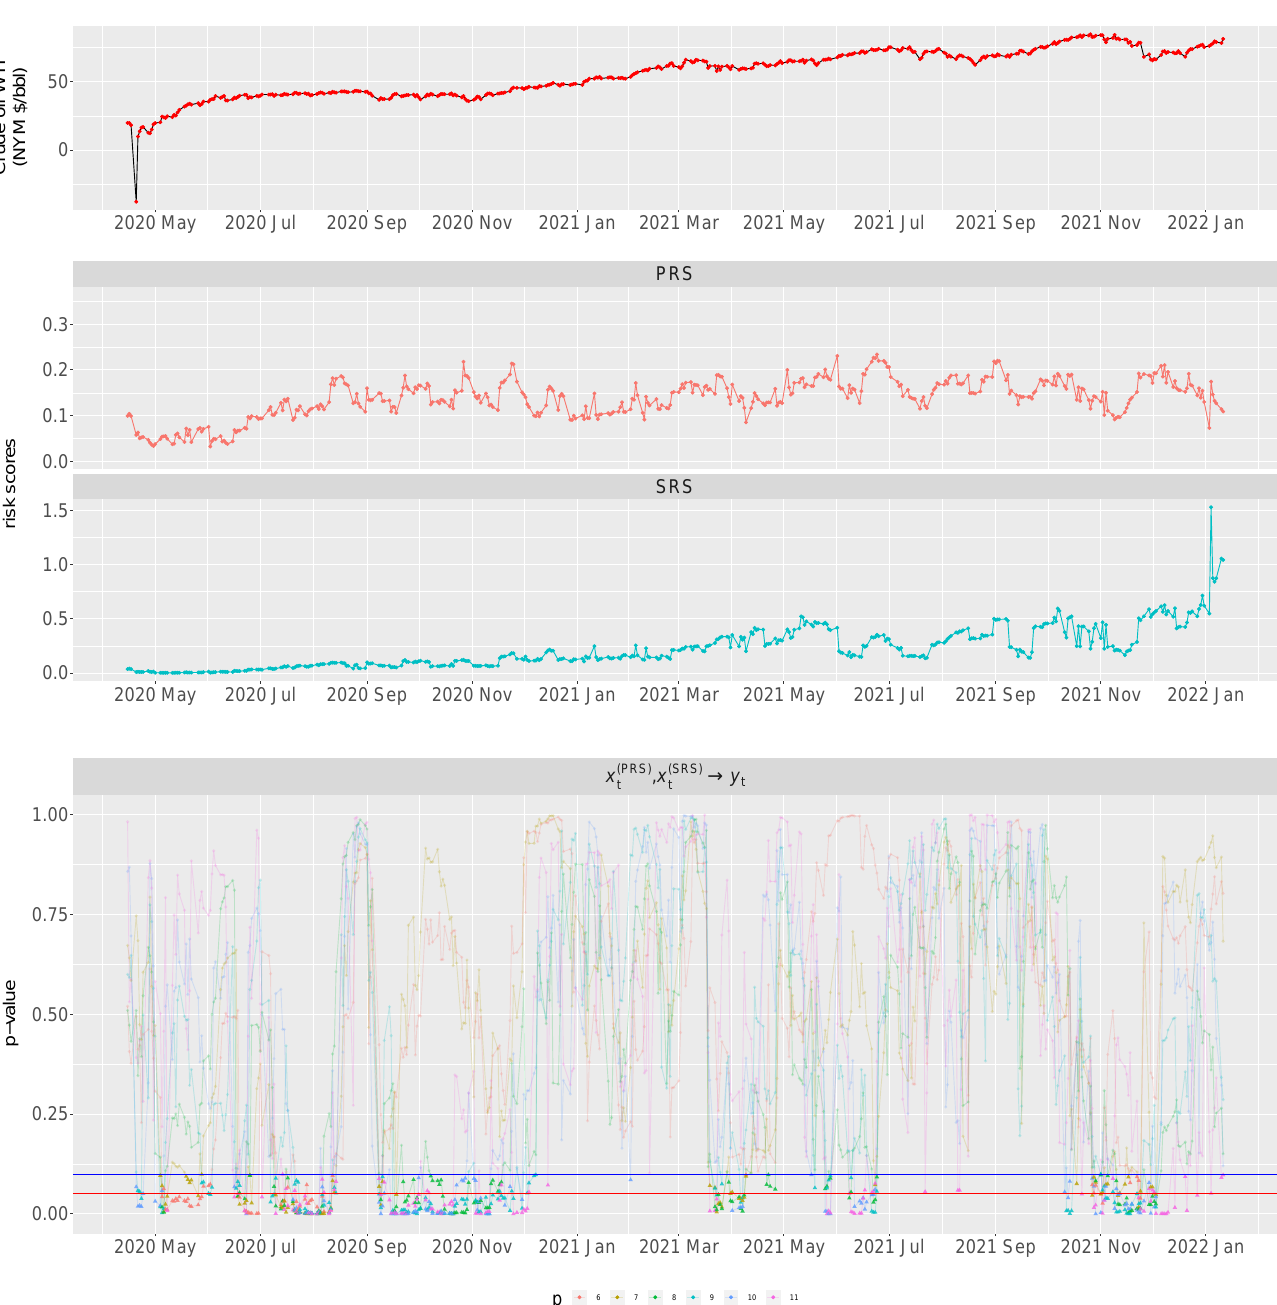
Figure 2. Time series plot of p -values (PRS and SRS; window width = 49; with different time lag p = { 6,7, . . . ,11 }